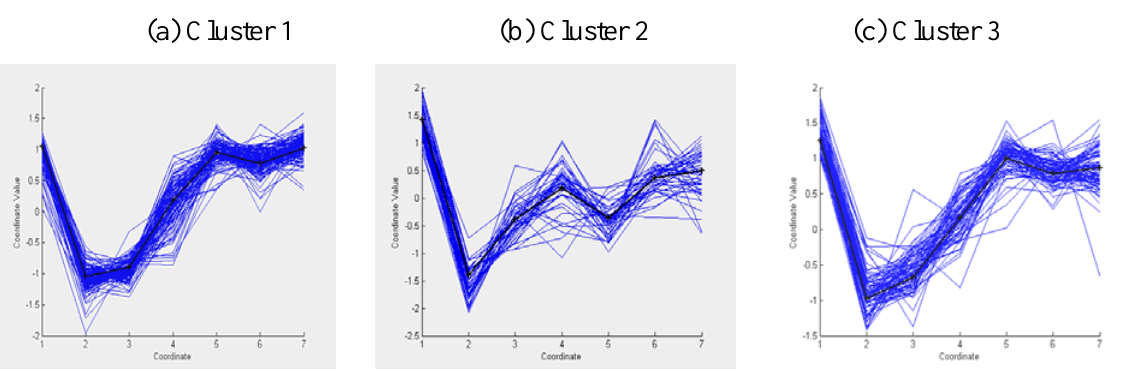
Figure 10. Cluster profile plots for clustering solution obtained by MODE-based clustering algorithm for yeast sporulation